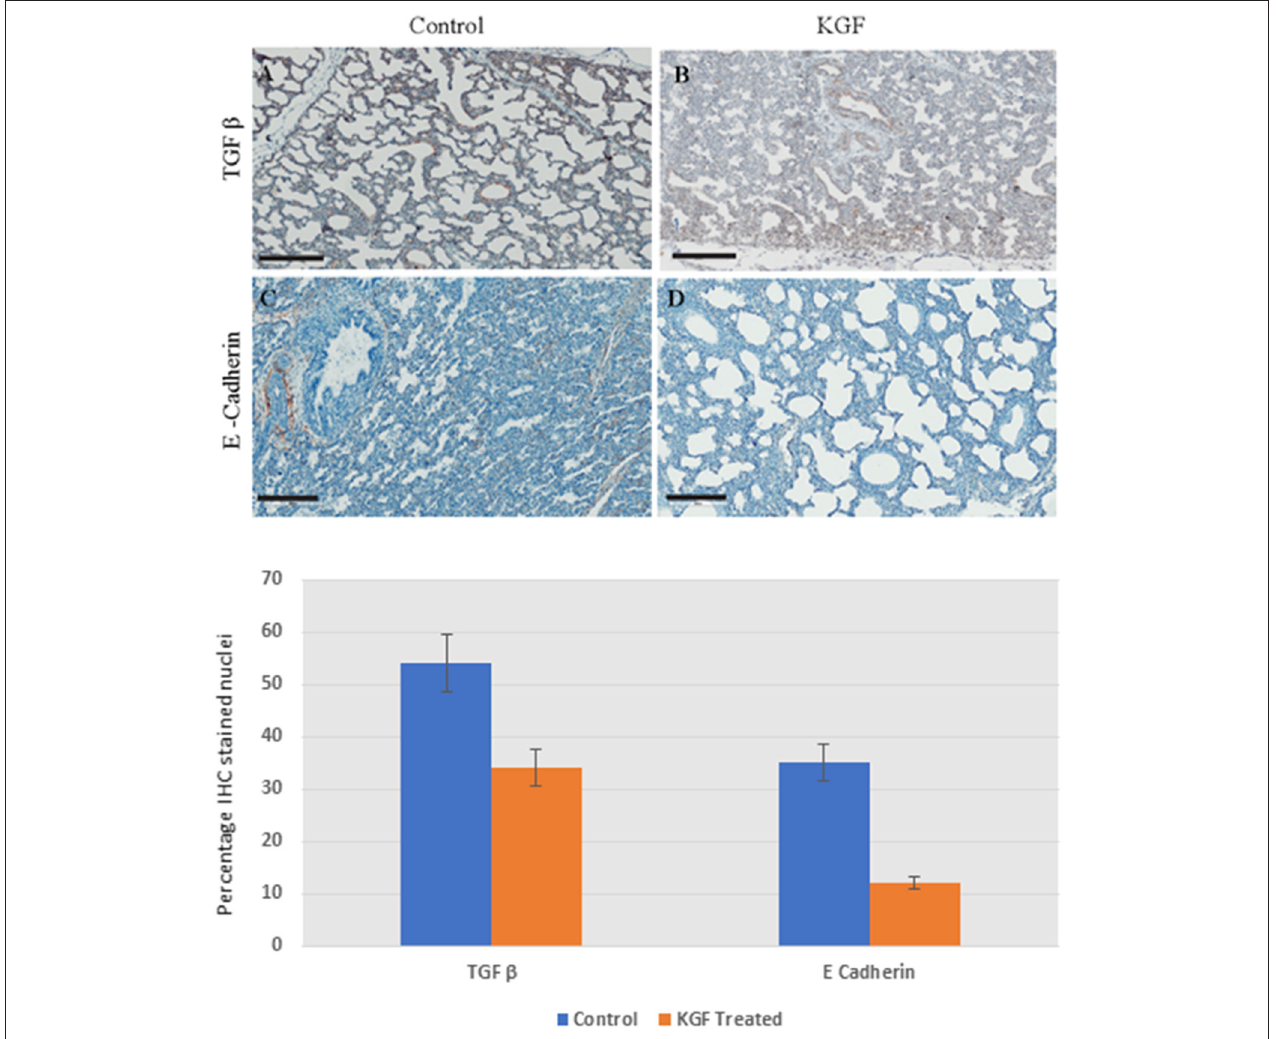
FIGURE 4 | Immunohistochemistry (IHC) performed on lung sections collected after 24 h of mechanical ventilation. (A,B) Transforming growth factor β (TGF- β ) is lower in KGF pretreated tissue than in control tissue (3.72 ± 0.08 vs. 5.31 ± 2.11, p < 0.05). (C,D) E Cadherin expression was attenuated with KGF pretreatment (1.27 ± 0.05 vs. 3.45 ± 1.81, p < 0.05). Scale bars are 200 µ